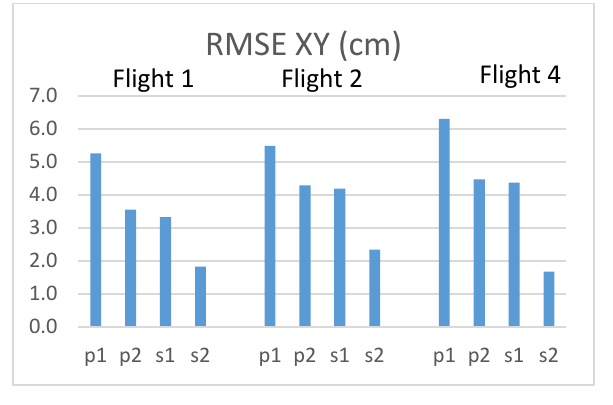
Figure 4. RMSE in horizontal coordinates at CP